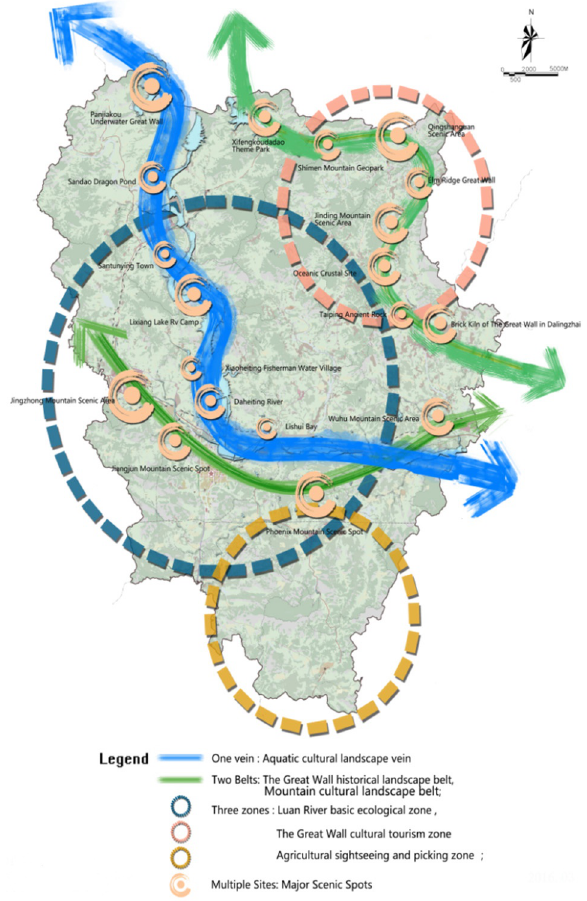
Figure 5. City Featured Landscape Planning Chart.